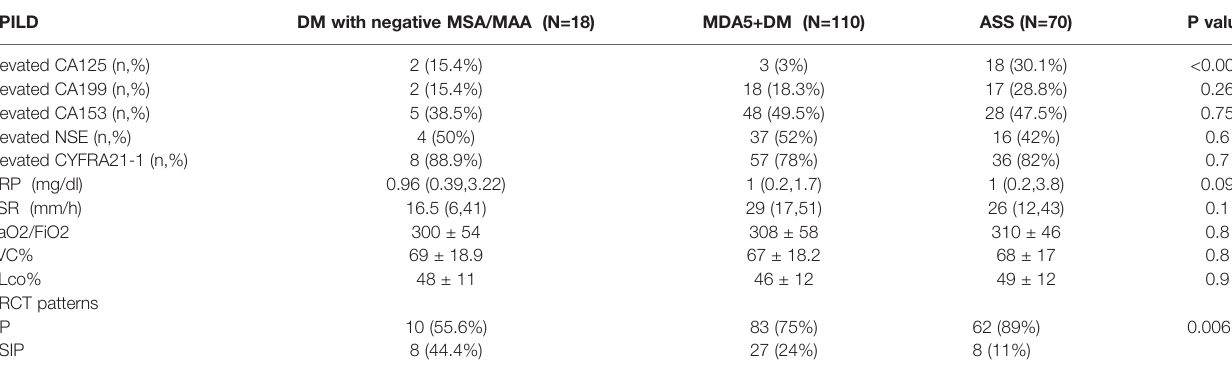
(Table 3 Breakdown): Continuous data were presented as M (mean) ± SEM (standard error of the mean), or medians (interquartile range). Binary data were presented as n (%) of the patients. DM, dermatomyositis; CK, creatine kinase; LDH, Lactate Dehydrogenase; FVC, Forced Vital Capacity; DLco, diffusing capacity for carbon monoxide; UIP, usual interstitial